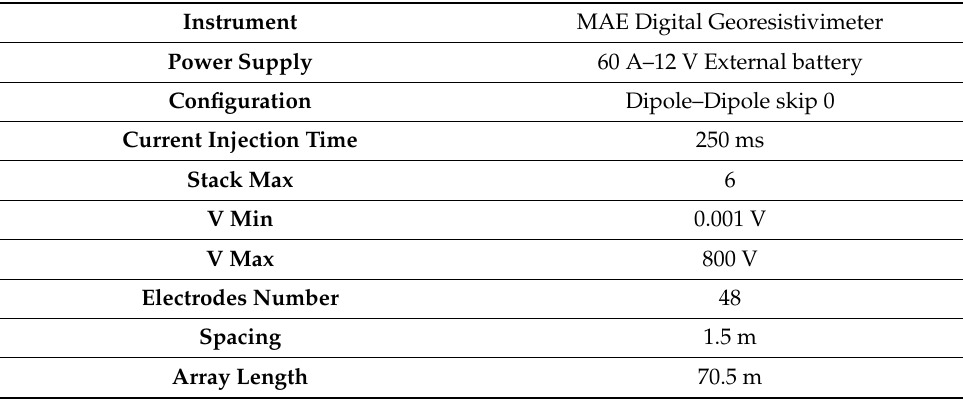
Table 1. ERT survey acquisition